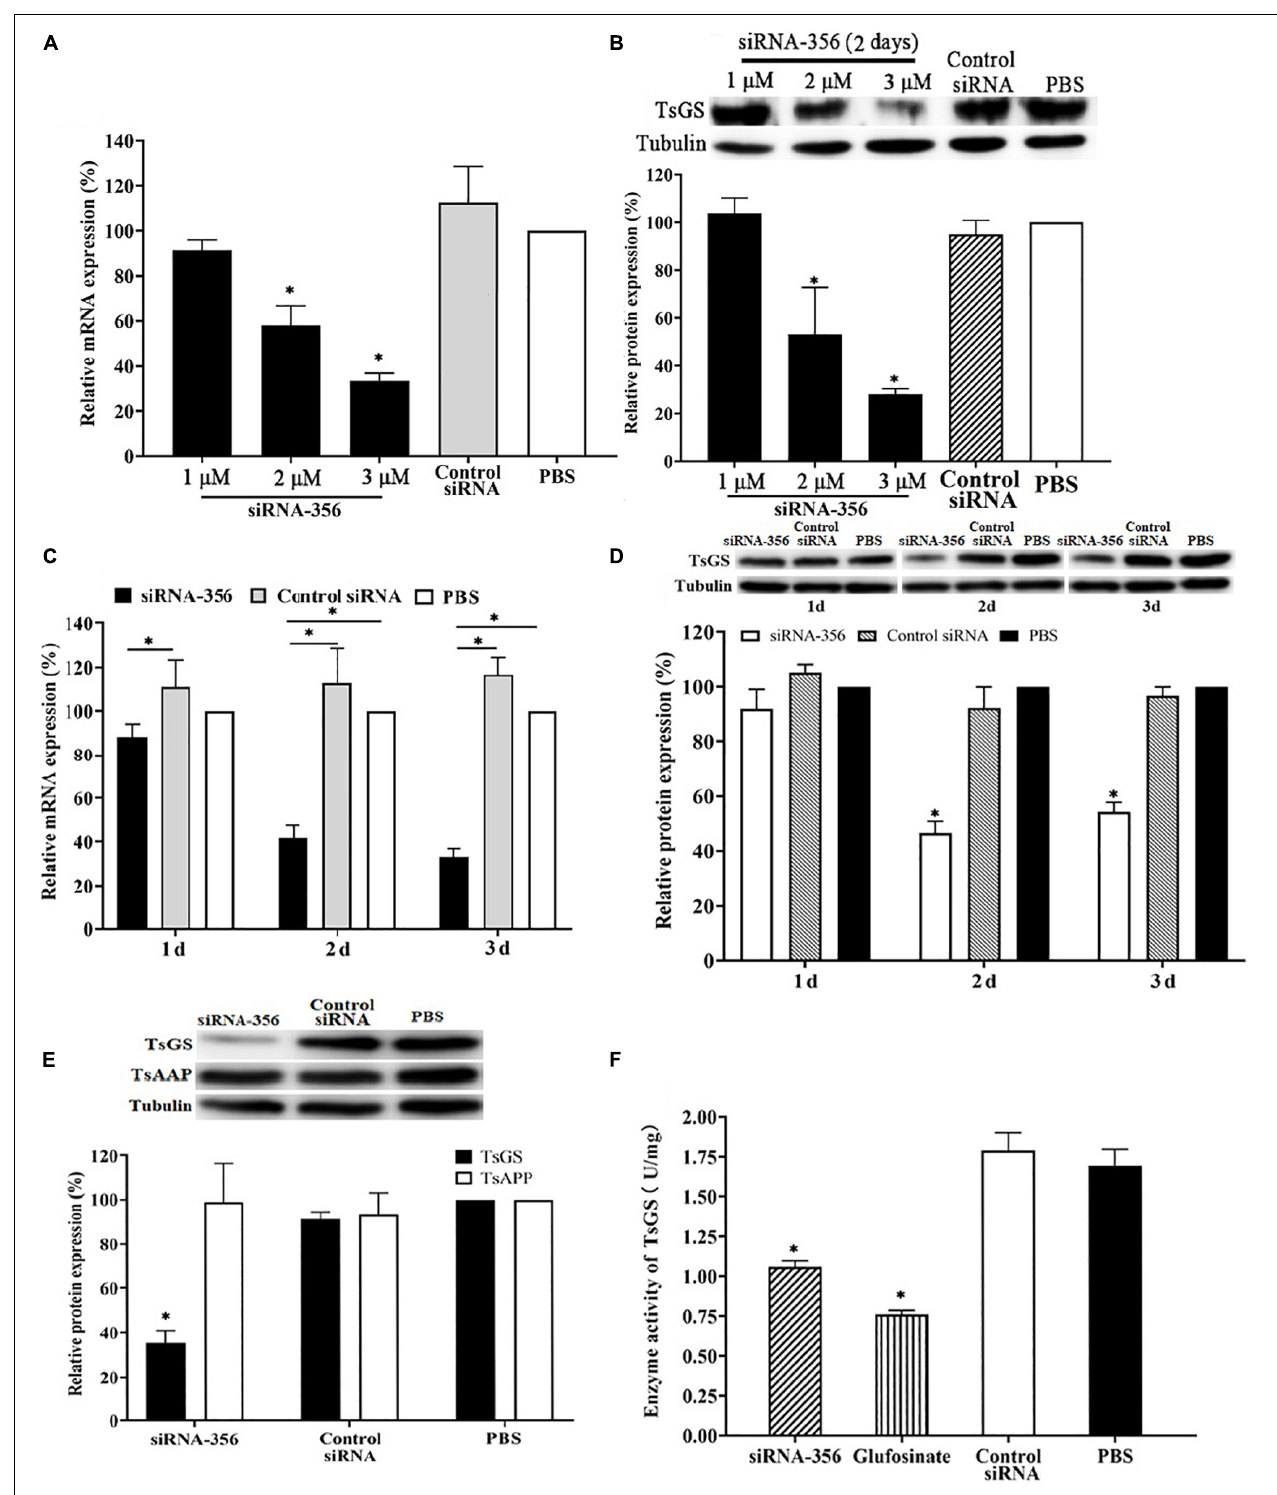
FIGURE 9 | Silencing of TsGS gene reduced the TsGS expression and enzyme activity. (A) Effect of various doses of siRNA-356 on TsGS transcription level. (B) Effects of various doses of siRNA-356 on TsGS protein expression. (C) TsGS transcription level at 1–3 days after treatment with 3 µ M siRNA-356. (D) TsGS expression level at 1–3 days after treatment with 3 µ M siRNA-356. (E) Expression levels of TsGS and Trichinella spiralis aspartyl aminopeptidase in muscle larvae (ML) treated using TsGS-specific siRNA-356. (F) Native TsGS enzyme activity to hydrolyze its substrate was significantly declined in siRNA-356 and inhibitor- treated ML. ∗ P < 0.05 compared to the phosphate-buffered saline